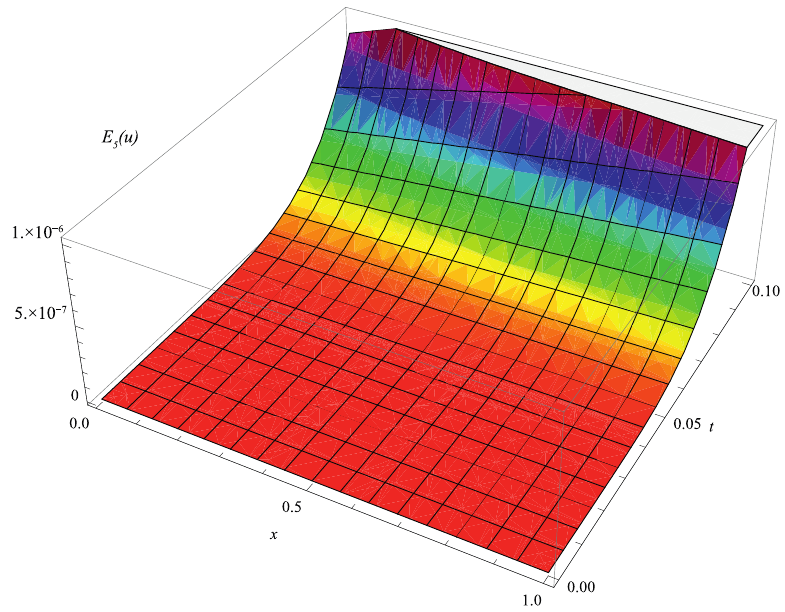
Figure 3. Plot of the absolute error at the level n = 5.